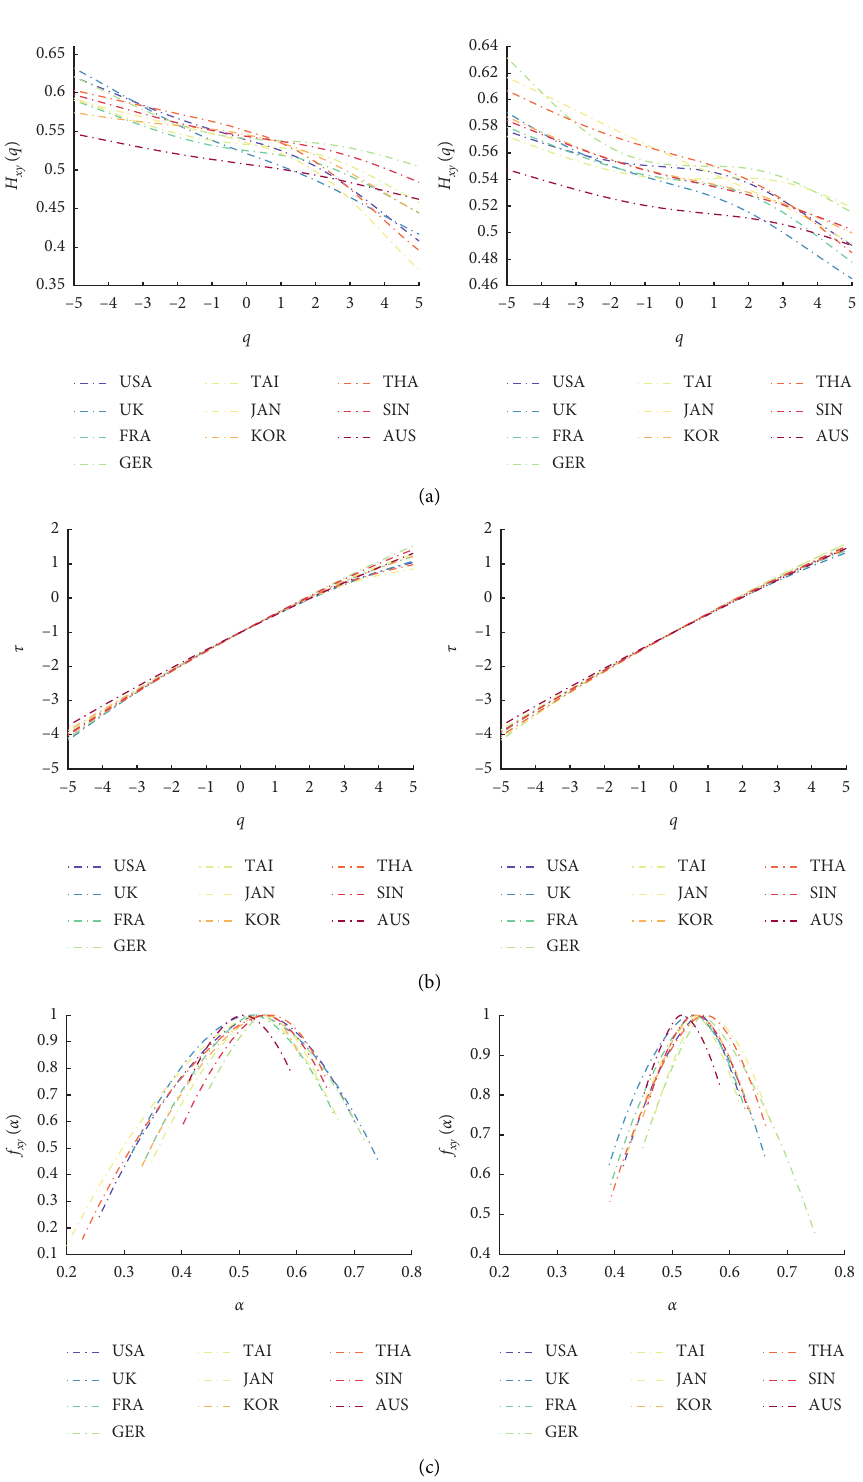
Figure 4: MF-DCCA analysis of AHA, AHH, and the other ten pairs for the postperiod. (a) Generalized Hurst exponent as a function of q . (b) Multifractal exponent as a function of q . (c) Singularity